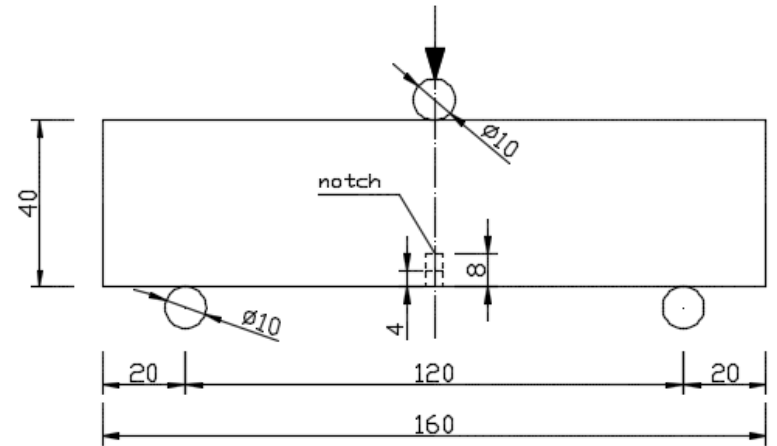
Figure 4. Setup for measurement of flexural strength.